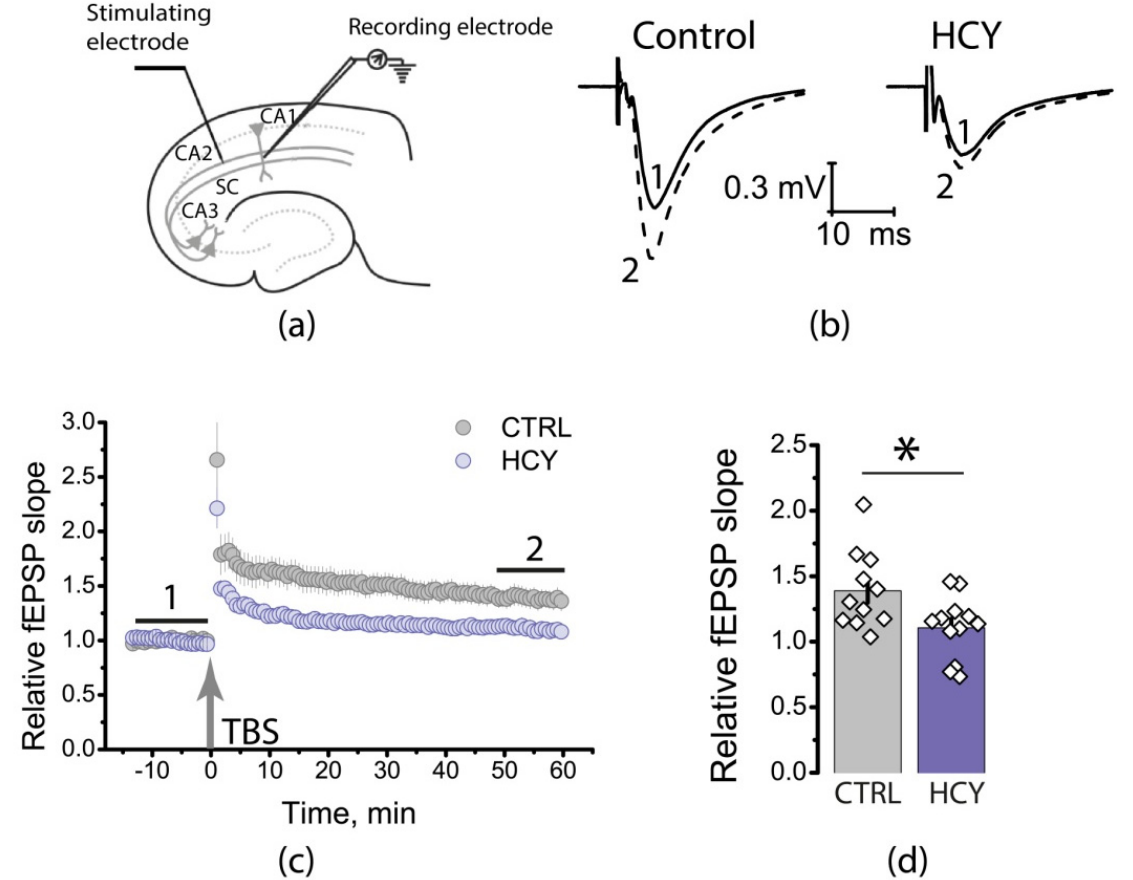
Figure 3. Long-term synaptic potentiation (LTP) is weakened in HCY rats. ( a ) Schema showing the positions of electrodes in the hippocampus. ( b ) Representative examples of fEPSP before induction (1) and 60 min after TBS (2). ( c ) Diagram showing changes in the value of the normalized slope of fEPSP in control (CTRL) and experimental (HCY) animals after theta-burst stimulation (TBS). ( d ) Diagram illustrates the differences in LTP between control (CTRL) and experimental (HCY) animals. * p < 0.05: a significant difference versus the control group ( t -test).